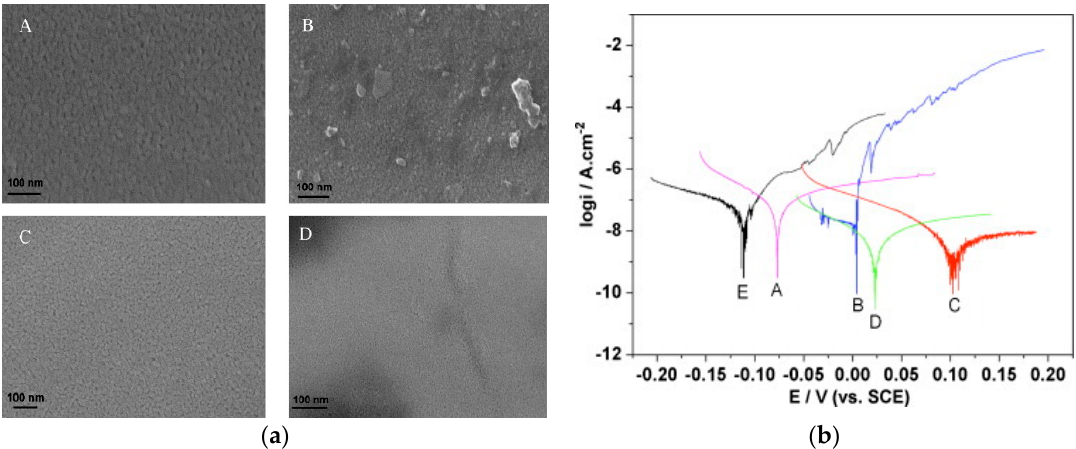
Figure 12. ( a ) SEM images of the different nano-TiO 2 coated 316L: (A) pure TiO 2 , (B) Cl–TiO 2 , (C) N–TiO 2 , (D) S–TiO 2 ; ( b ) Polarisation curves for bare 316L and the different TiO 2 coatings in 0.5-M NaCl solution: (A) pure TiO 2 /316L coatings; (B) Cl-doped TiO 2 /316L coatings; (C) N-doped TiO 2 /316L coatings; (D) S-doped TiO 2 /316L coatings; (E) bare 316L [77].